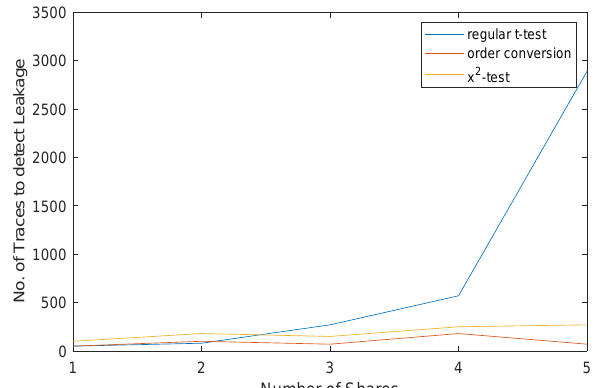
Figure 12: Number of traces to detect leakage for different number of shares using three different